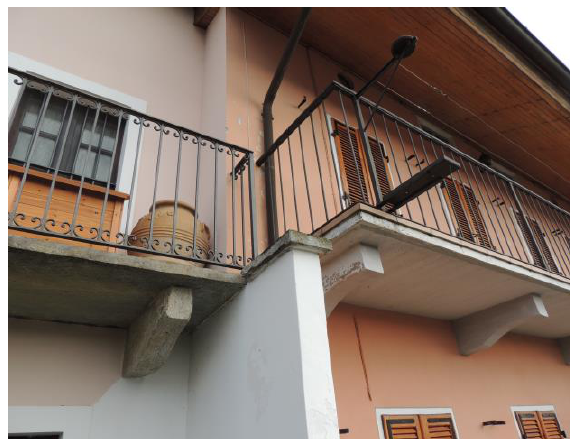
Figure 10. Building D - Reintegration of the upper part of the walls and of the roof (credits Manuela Mattone).